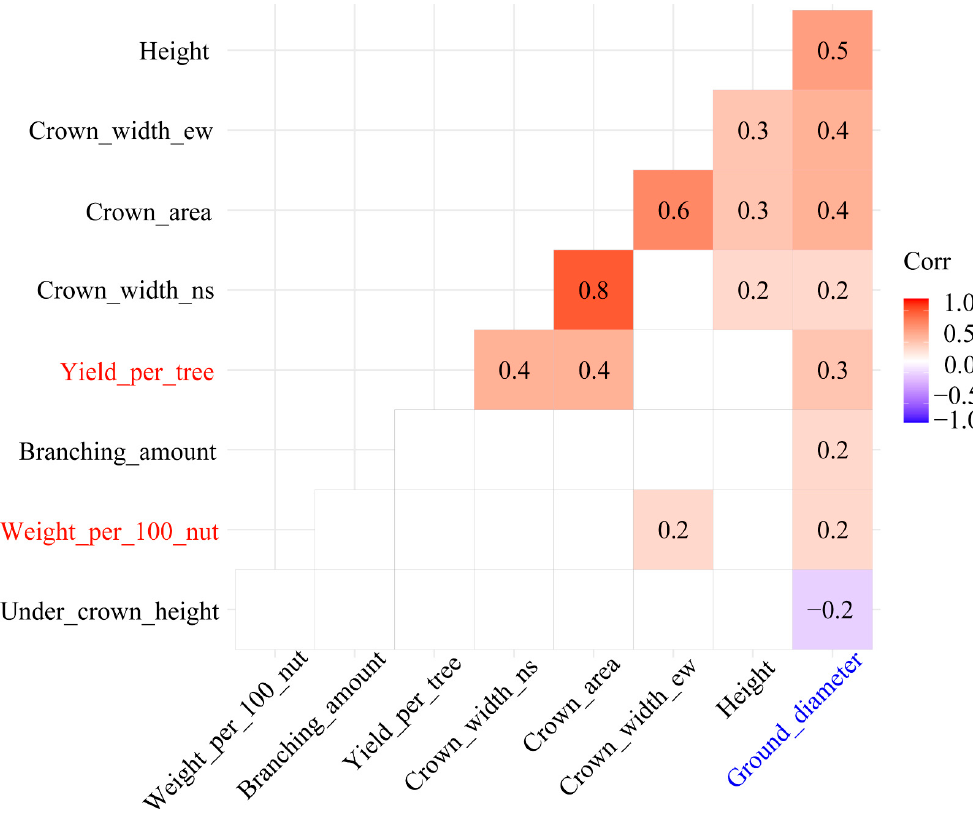
Figure 2. Correlation coefficients among traits were examined with a nonparametric test (Spearman test). The red and light purple colors in the grids indicate significant positive and negative correlations, respectively. The significance level is 0.05. The digit number in each cell is the correlation coefficient, which ranges from − 1 to 1.